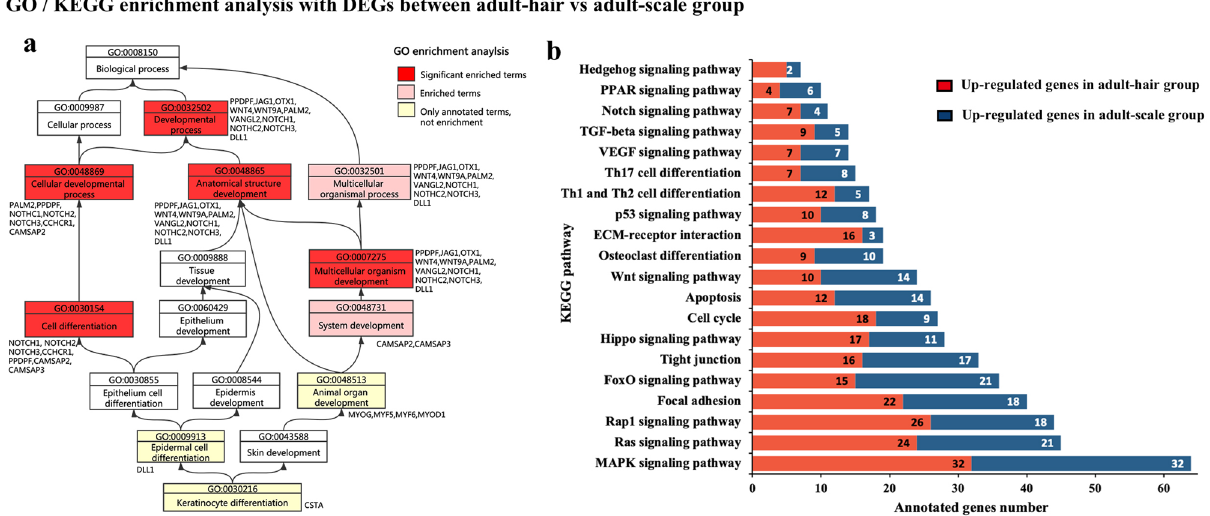
Figure 4. GO and KEGG enrichment analysis of DEGs between adult-hair vs adult-scale group. (a ) Directed acyclic graph of GO enrichment analysis associated with cell differentiation; ( b ) Signalling pathways related to development and differentiation of skin appendages in KEGG enrichment